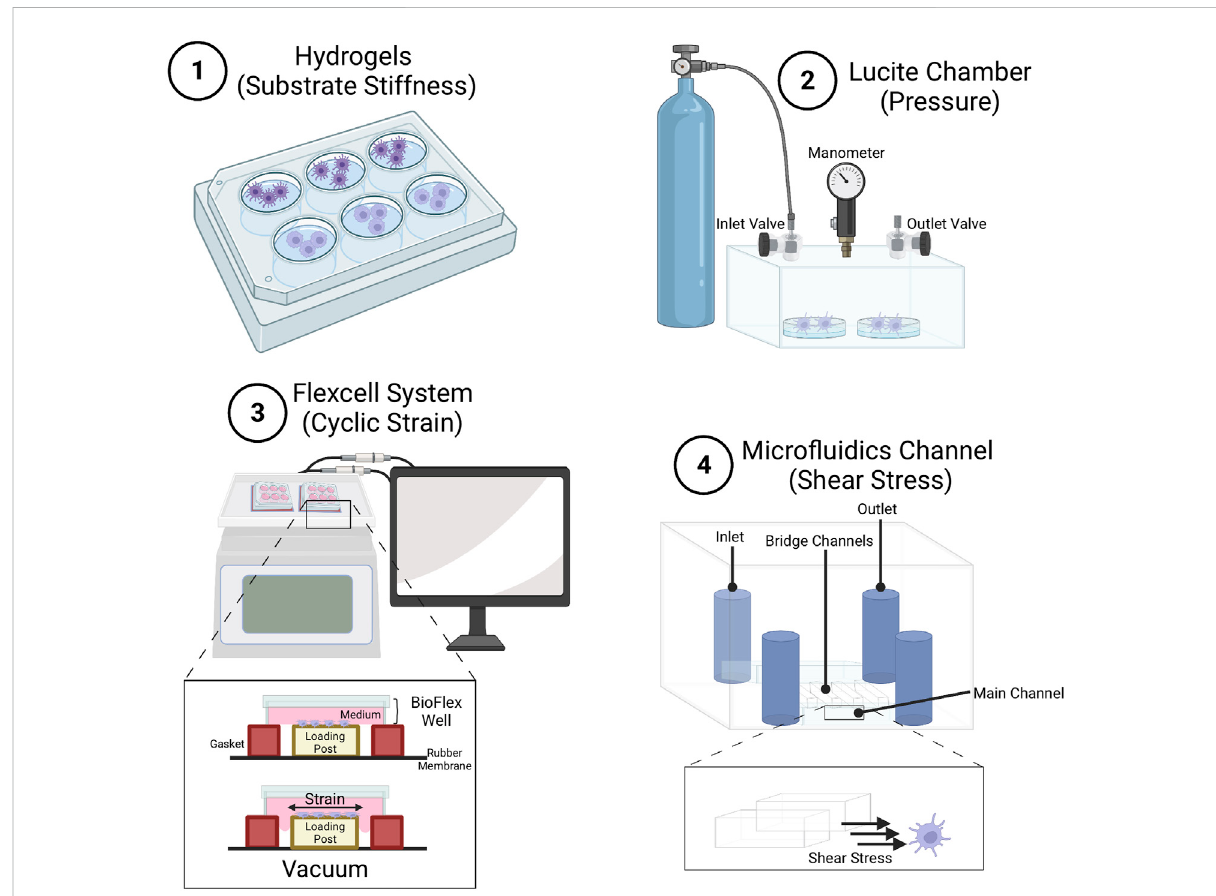
FIGURE 3 Methods for studying effects of mechanical stimuli on macrophages and dendritic cells. (1) Hydrogels used to study the effect of substrate stiffness of various compliance on immune cell development, differentiation and function. Common hydrogels include poly-dimethyl-siloxane hydrogels (as described in (Lee et al., 2022)), and polyacrylamide hydrogels (Shaheen et al., 2017). Lucite chamber used to apply pressure to cells. Pressure can be controlled using an airtight Lucite box with an inlet valve for gas application, and an outlet valve connected to a manometer. Boxes are prewarmed to 37 ° C to prevent internal temperature and pressure fl uctuations (as described in (Craig et al., 2008)) (Oakes et al., 2009). Flexcell system to apply strain to cells. Cyclic strain can be applied by deformation of the Bio fl ex well plate through regulated air vacuum suppliedto the bottom of the plate, causing the membrane to stretch (Adlerz et al., 2016). Micro fl uidics channel to apply shear stress on cells. Cells are cultured within the lower main channel, while medium is injected into the upper channel. Cells get exposed to shear stress generated through the bridge channel (as described in (Kang et al., 2021)), and mechanical forces experienced by cells get calculated using computational